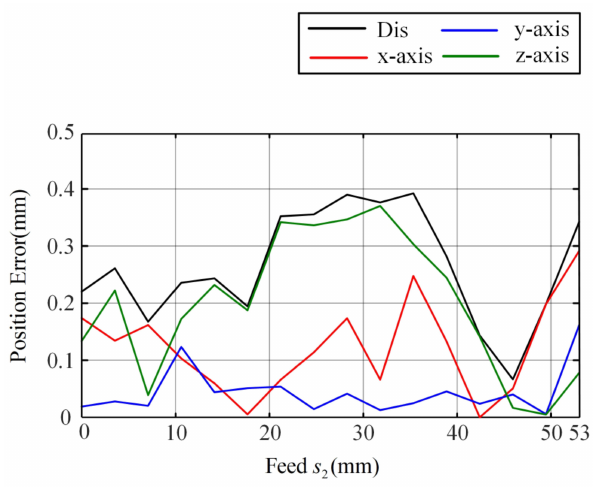
Figure 8. Improved model feed experimental position